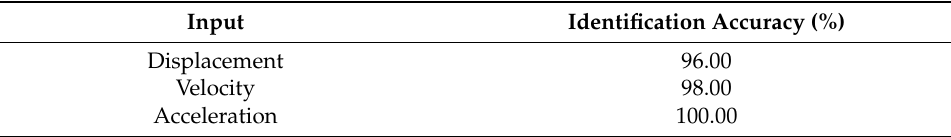
Table 6. Identification results for the vehicle